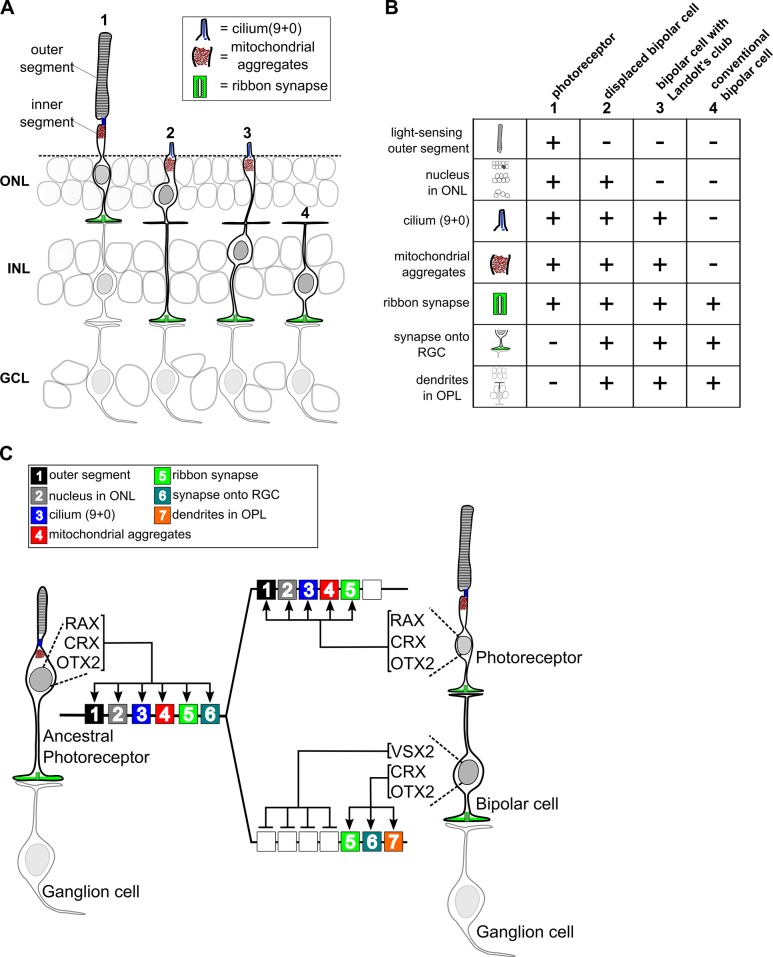
Evolutionary model for the divergence of bipolar cells from photoreceptors.(A) Schematic depiction of photoreceptors (1), conventional bipolar cells (4), and two ‘transitional’ cell types with cellular features intermediate between those of photoreceptors and conventional bipolar cells: displaced bipolar cells (2) and bipolar cells with Landolt’s club (3). (B) Table of individual cellular features (referred to in Arendt et al. as ‘apomeres’) possessed by photoreceptors, bipolar cells, or both cell classes. (C) Evolutionary model for the divergence of present-day photoreceptors and bipolar cells from a common ancestral photoreceptor type. We propose that the ancestral photoreceptor (possibly present in a hagfish-like ancestor) expressed cell type-specific genes via both K50 HD TFs (CRX and OTX2) and a possibly weakly activating Q50 HD TF (RAX). The emergent expression of a strongly repressive Q50 HD TF (VSX2) in bipolar cells then permitted silencing of selected photoreceptor gene modules underlying the formation of defined photoreceptor apomeres (e.g., outer segment). Selective expression of activating Q50 HD TFs in ‘transitional’ bipolar cell types may have allowed the derepression of specific photoreceptor apomeres (e.g., cilium formation, mitochondrial aggregates). Novel bipolar-specific apomeres (e.g., dendrites in the outer plexiform layer [OPL]) may have evolved via co-option of other gene expression programs.